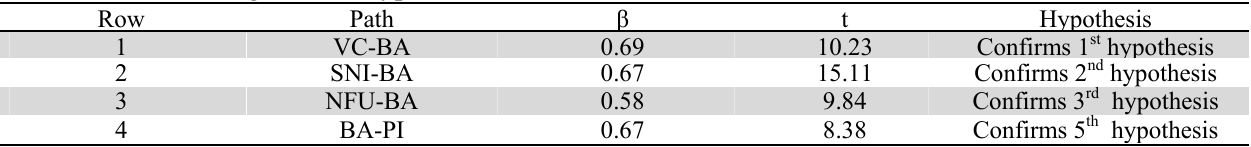
The results of testing various